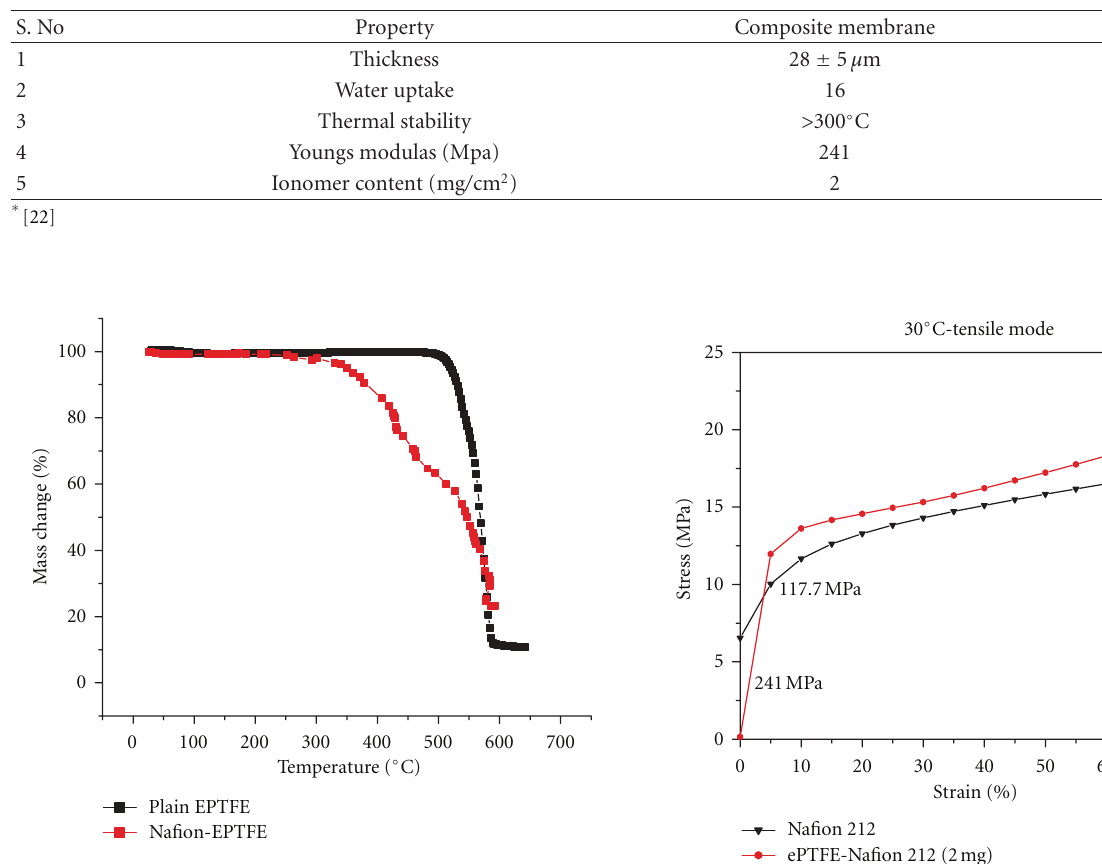
Table 2: Comparison of the properties of the composite membrane with Nafion 112 membranes.